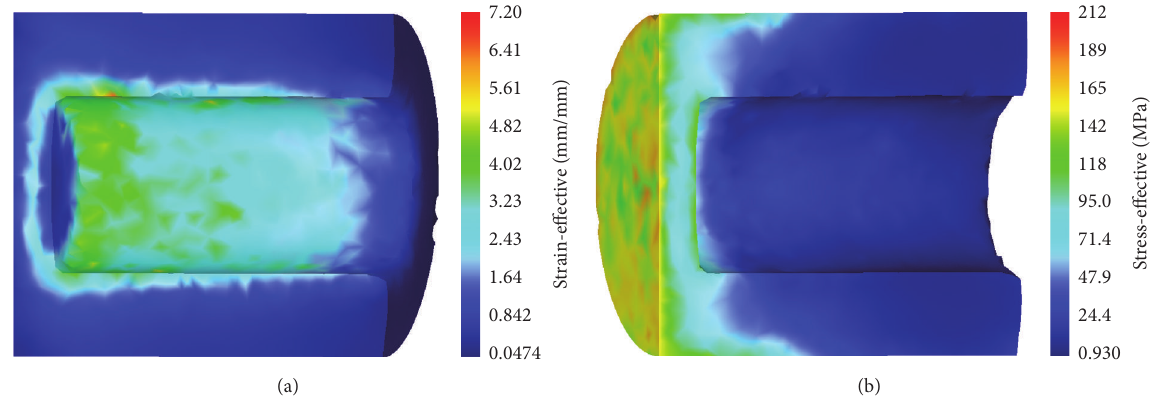
Figure 17: Simulation result of billet deformed with the elements number of 30787: (a) strain; (b) stress.